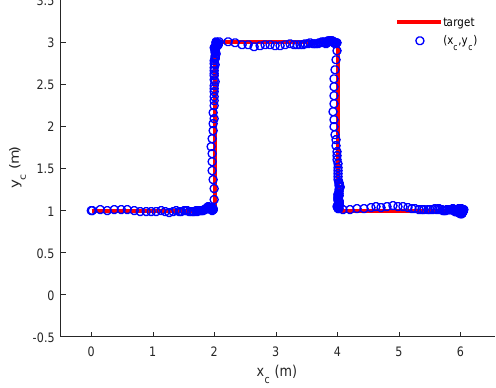
Figure 12. The real trajectory of the OMR.